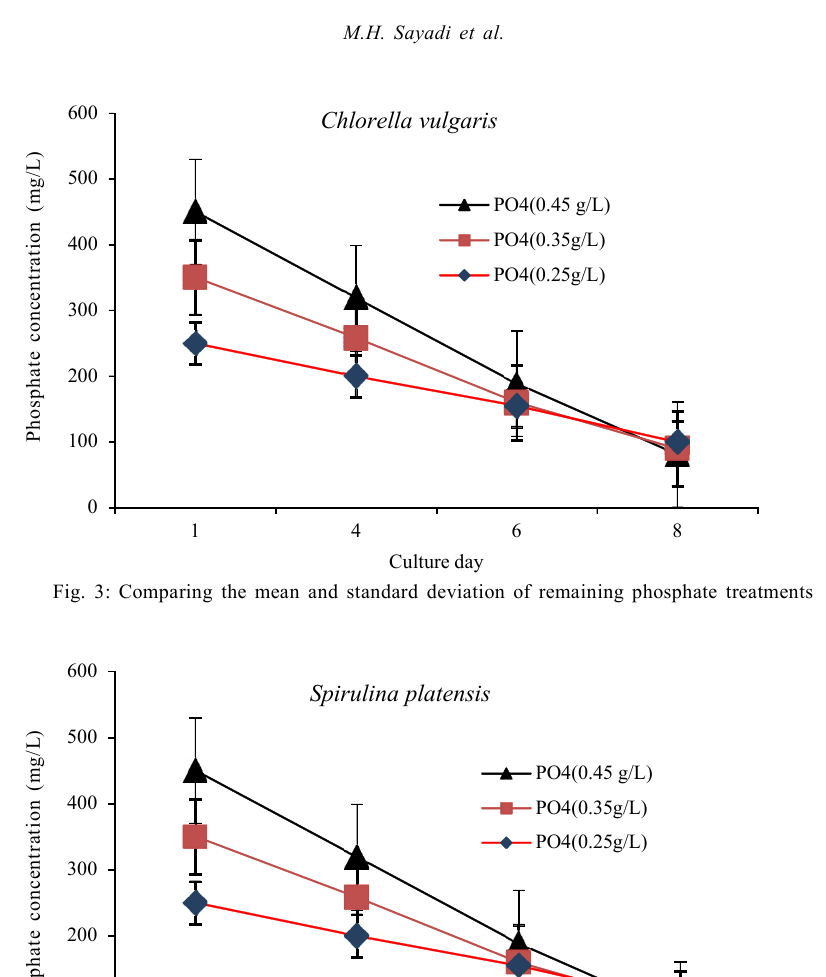
Figs. 3 and 4 represent the phosphate removal at Spirulina platensis.